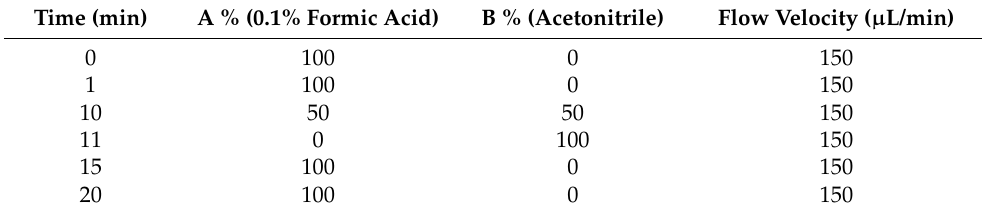
Table 2. Gradient program for HPLC